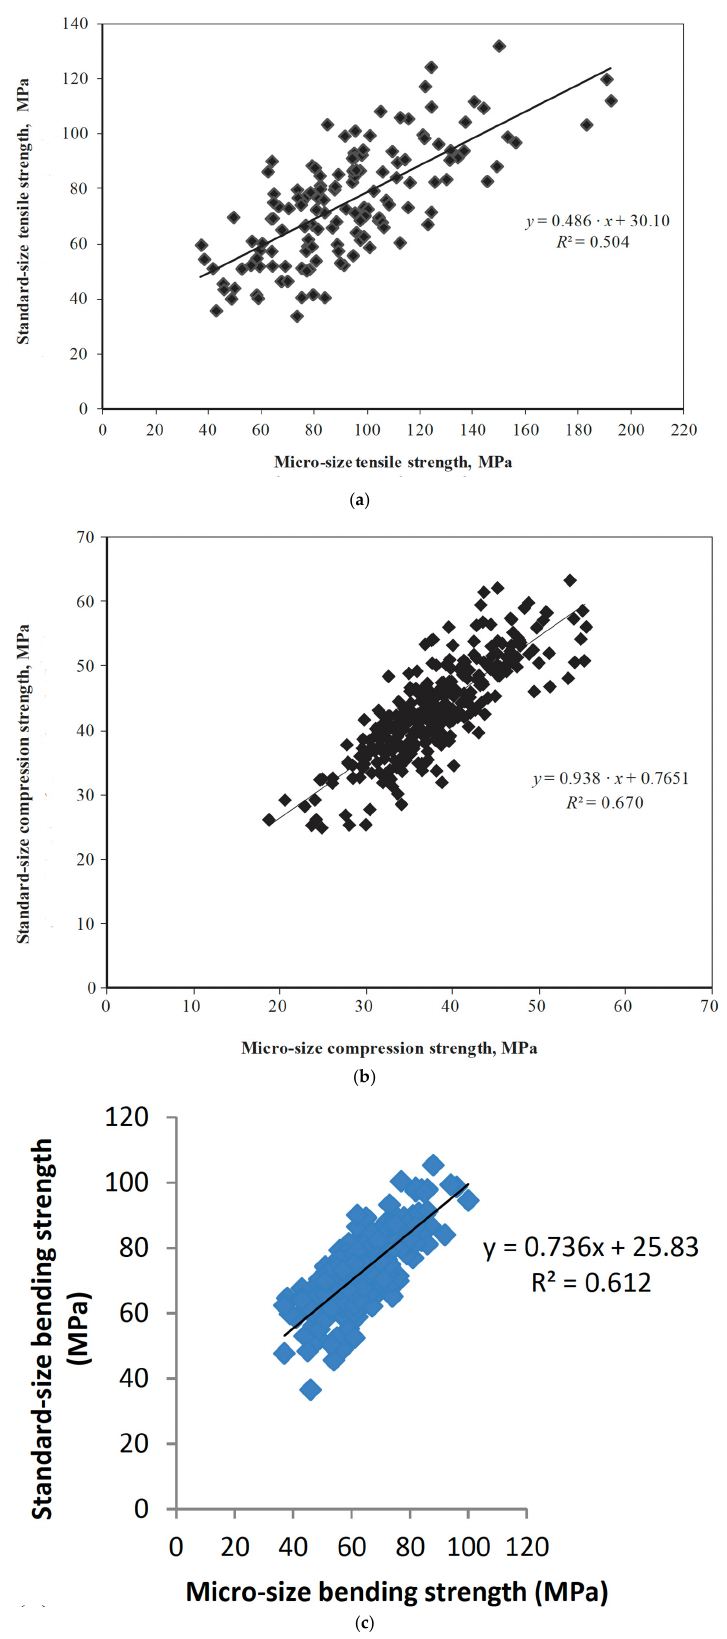
Figure 51. Comparison of the strengths of standard and micro-sized specimens of Pinus sylvestris in ( a ) tension (from [88]), ( b ) compression (from [88]) and ( c ) bending (from [168]. Zhou et al. analyzed the effects of varying both lumber grade and specimen width on the elastic modulus of Chinese Larch ( Larix gmelinii ), [131]. Grading was performed visually on the basis of the observed defects. Their data do not show any compelling over- all trends, and there is a large variation found within the data obtained from a single grade and width (Figure 52) [169].